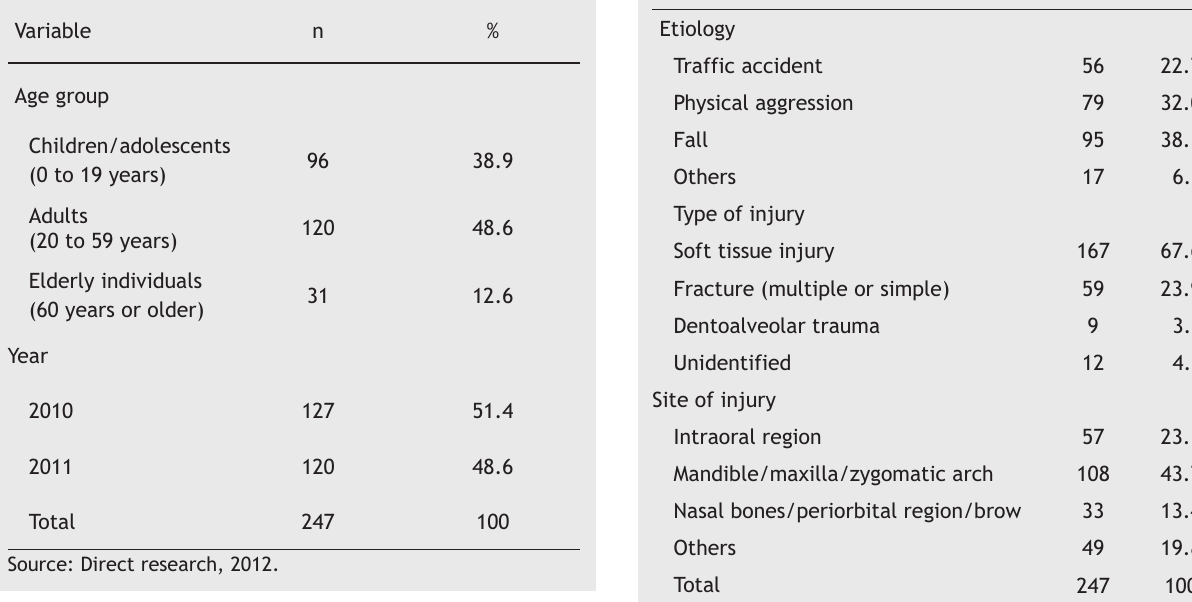
Table 1 Percentage distribution of age groups and year of occurrence of facial trauma: Campina Grande, Brazil, 2012 (n = 247).